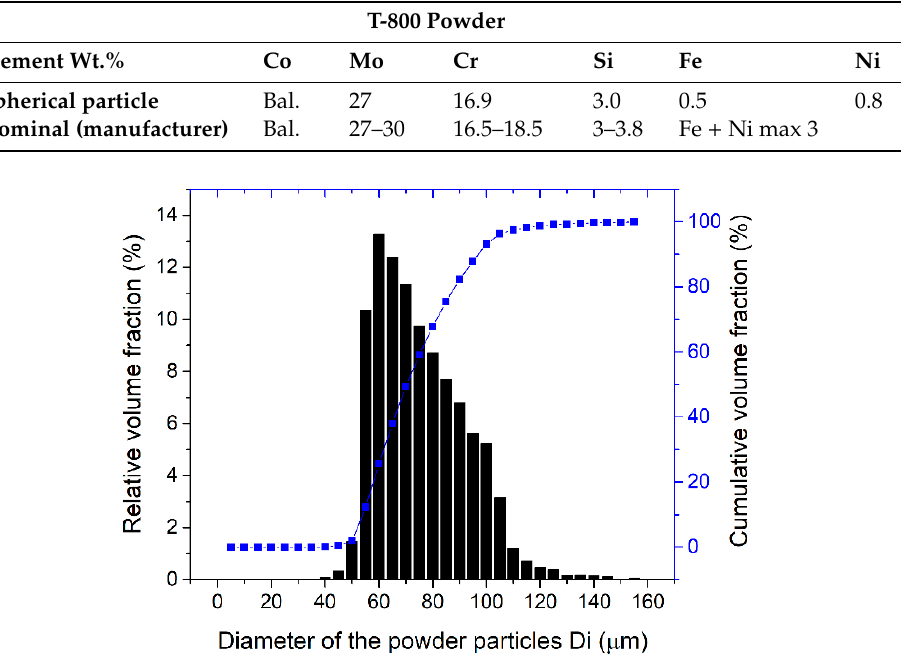
Figure 2. Particle size distribution of the T-800 powder employed in this work.